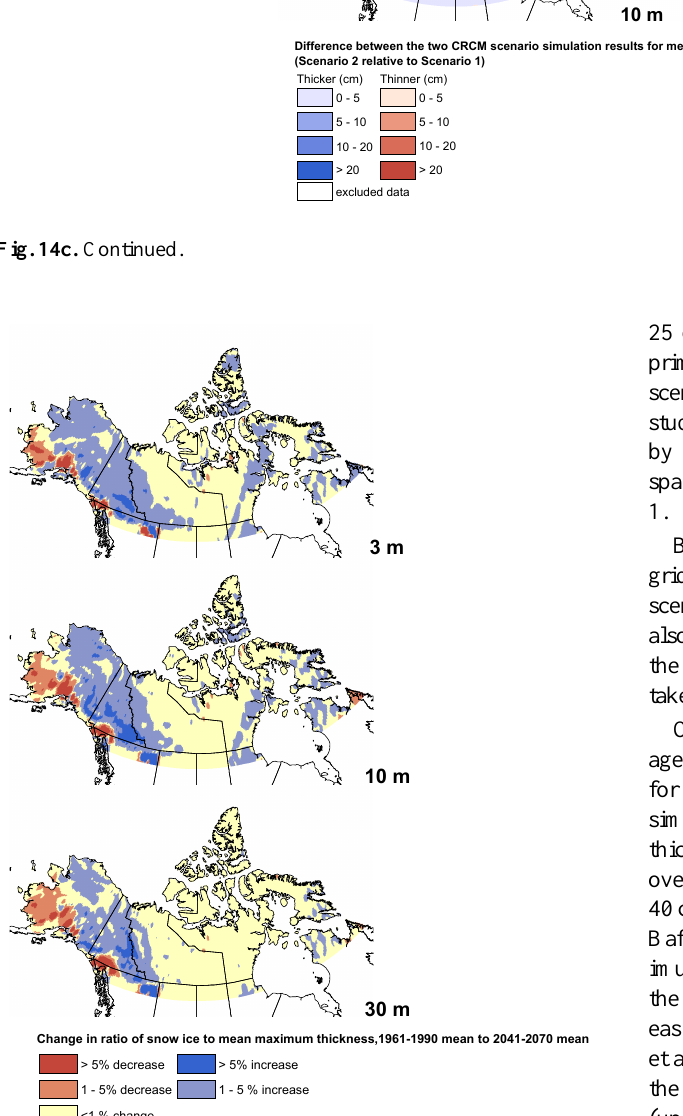
Fig. 15. Change in snow ice thickness to total ice thickness from 1961–1990 to 2041–2070